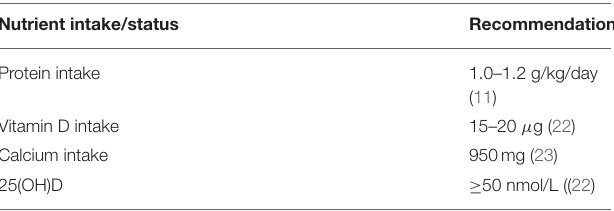
TABLE 1 | The international recommendation for protein, vitamin D, and calcium intake, and 25(OH)D concentration. Nutrient